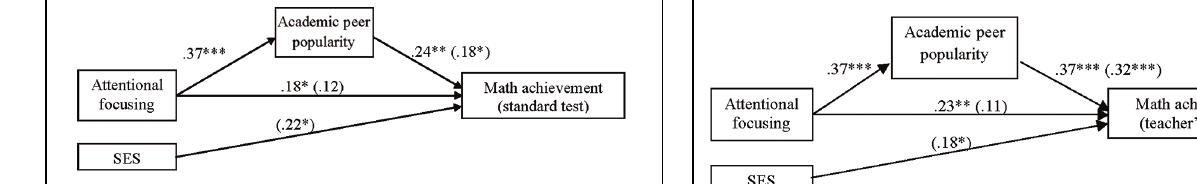
Frontiers in Psychology |